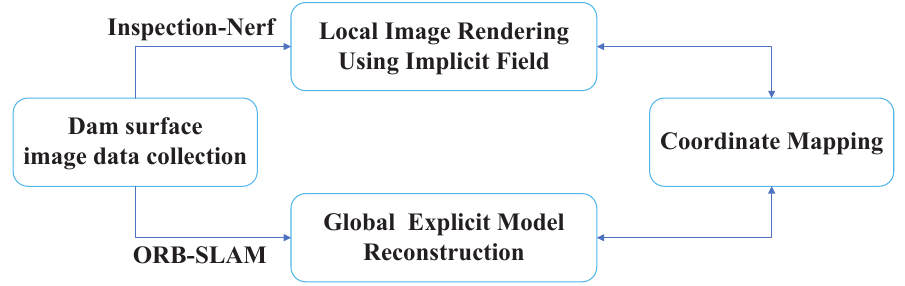
Figure 2. Flowchart of the proposed global-to-local view